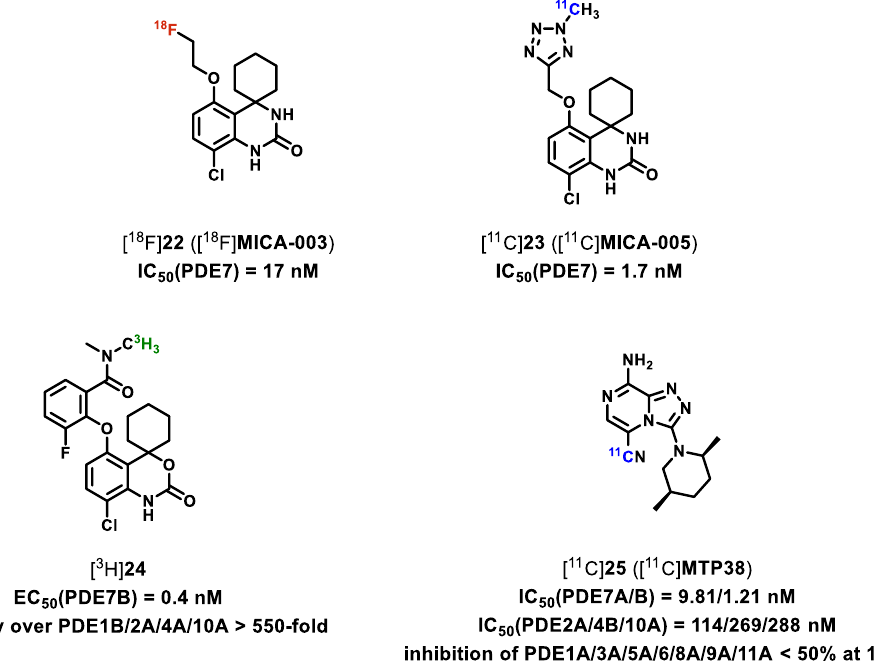
Figure 5. Molecular structures and IC 50 or EC 50 values for the PDE7 isoforms of ([ 18 F]) 22 and ([ 11 C]) 23 [96,97], ([ 3 H]) 24 [98], and ([ 11 C]) 25 [99].